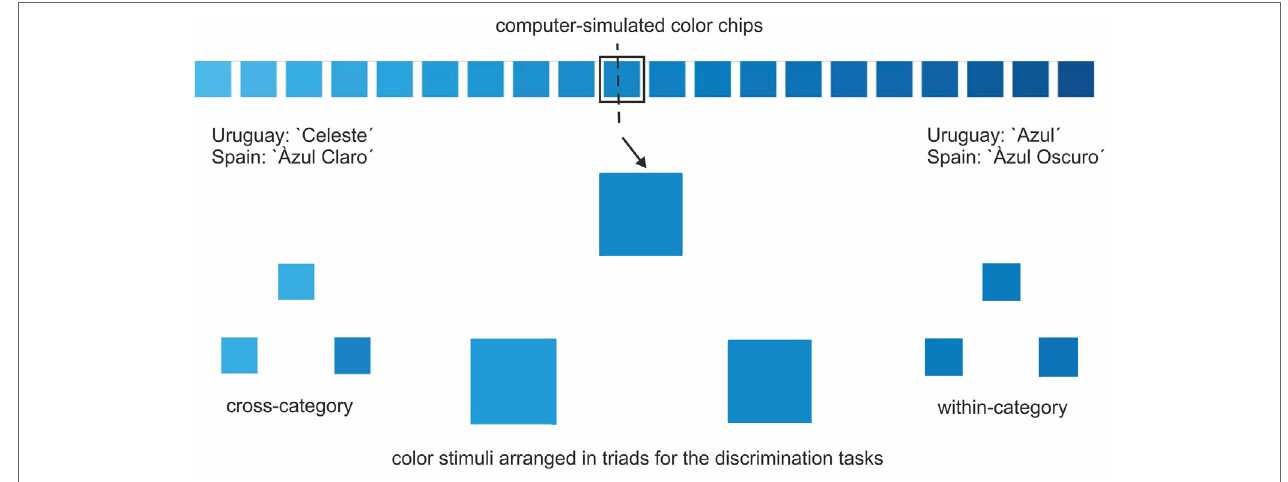
FigUre 1 | Illustration of the stimuli employed in the experimental tasks. Top: color chips ranging from light blue to dark blue. Bottom: middle: example of a triad used in the discrimination task; left: example of a cross-category comparison; right: example of a within-category comparison.